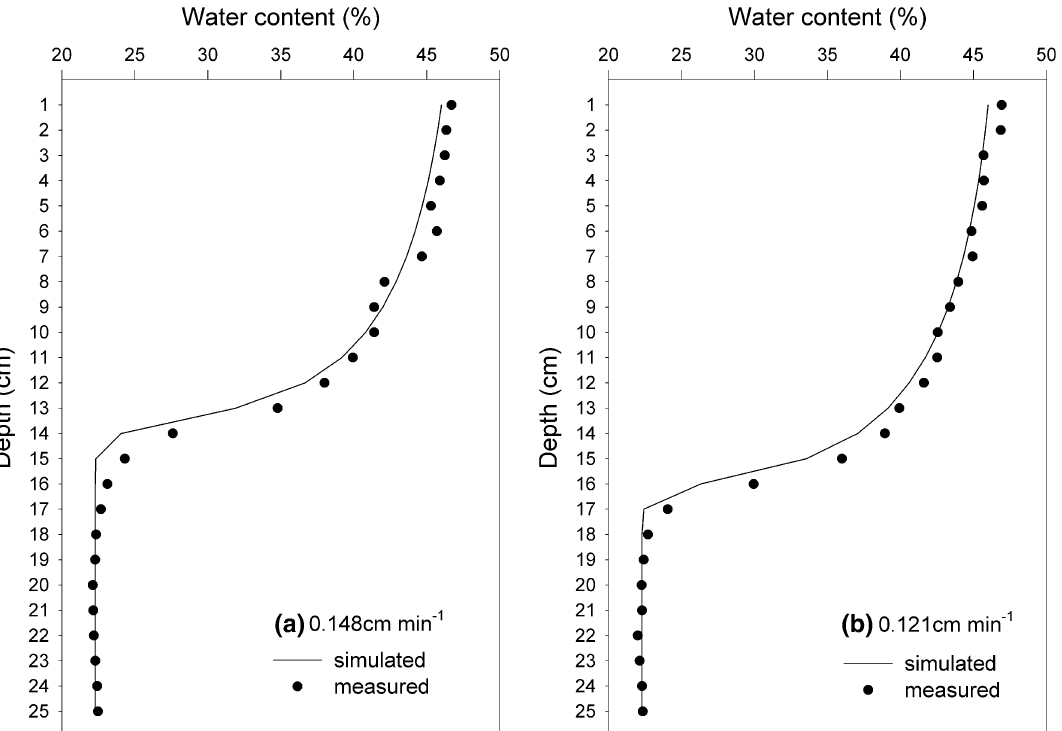
Fig. 3 Comparison of model results with the experimental soil moisture content for two artificial rainfalls with both soybean coverage and exist- ing plough pan